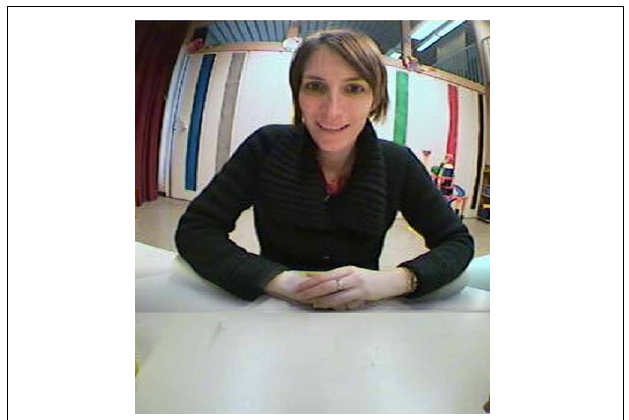
FIGURE 3 | Image of the interaction with the experimenter recorded from the WearCam. The shown image was taken into account in the statistical analysis. In fact, the adult interacting with the child makes a facial expression (smile) that is directed to the child wearing the eye-tracker. Moreover, there is no object of interaction visible in the child’s field of view. see Figure 3 . The automatic tracker has an accuracy of about